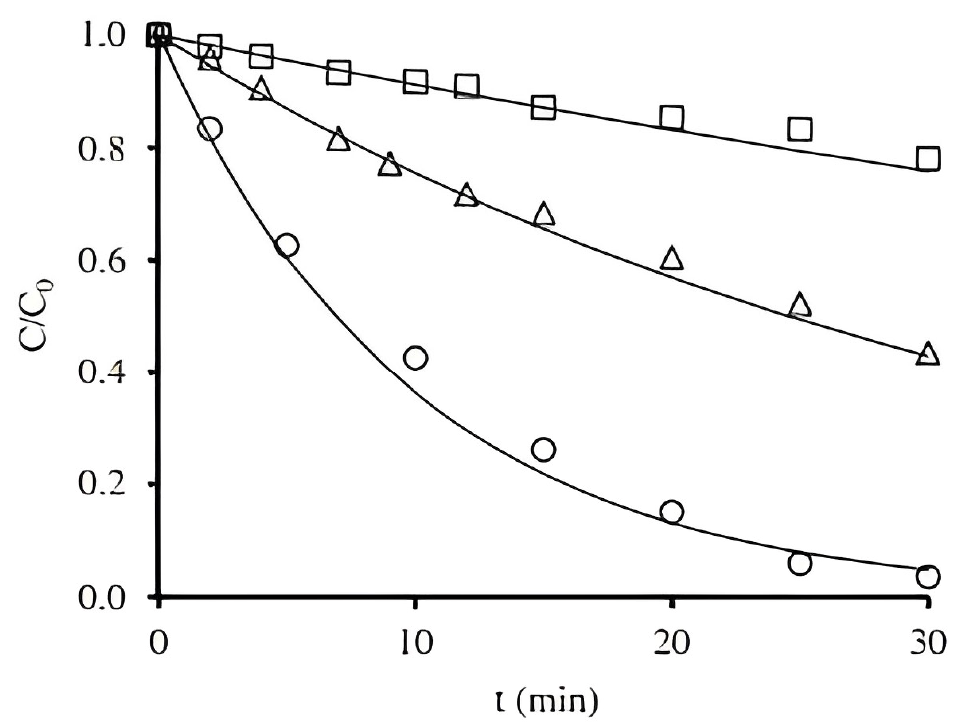
Figure 4. Influence of the type of water on the photodegradation of clopyralid (CLP) by UV radiation. [CLP] 0 = 25 mg/L. ( □ ) wastewater, ( △ ) tap water, and ( ○ ) ultrapure water. Reprined/Adapted with permission from [125], 2022, Elsevier (License Number 5336460765282).